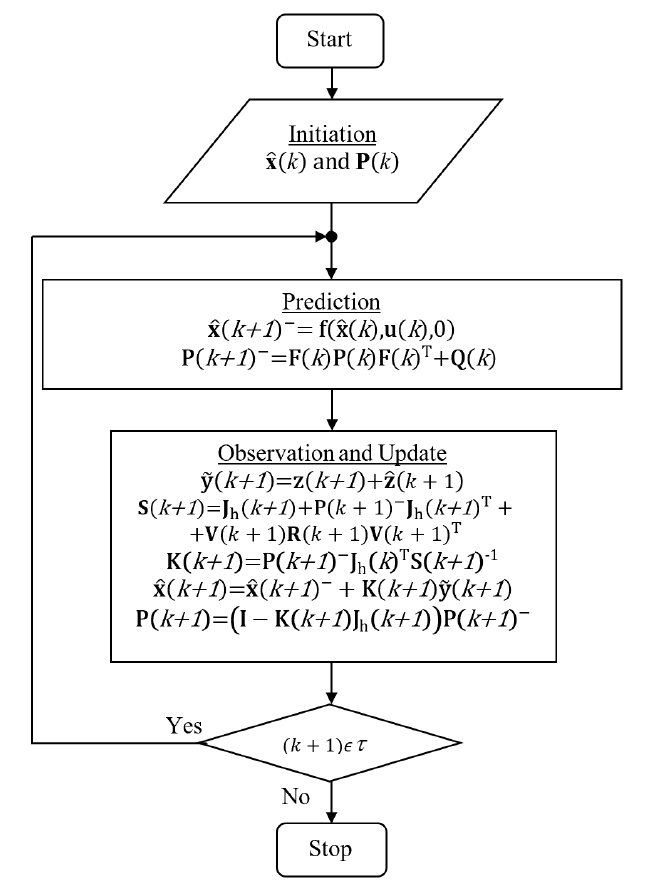
Figure 1. Algorithm of the estimation of the vector state (cid:98) x ( k + 1 ) using Extended Kalman